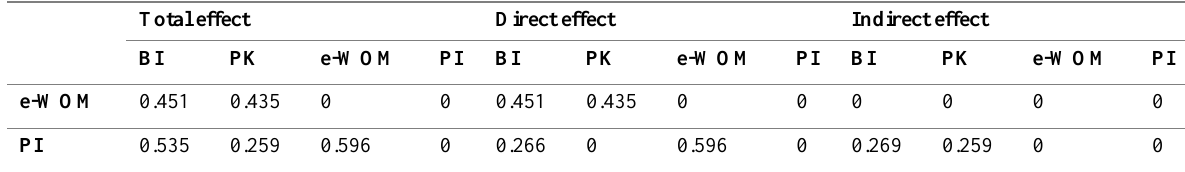
Table 3: Effect of Exogenous Variables on Endogenous